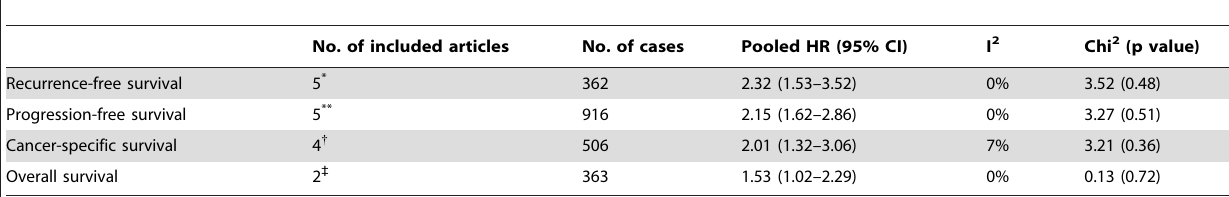
Table 4. Sensitivity analysis in non-muscle invasive bladder